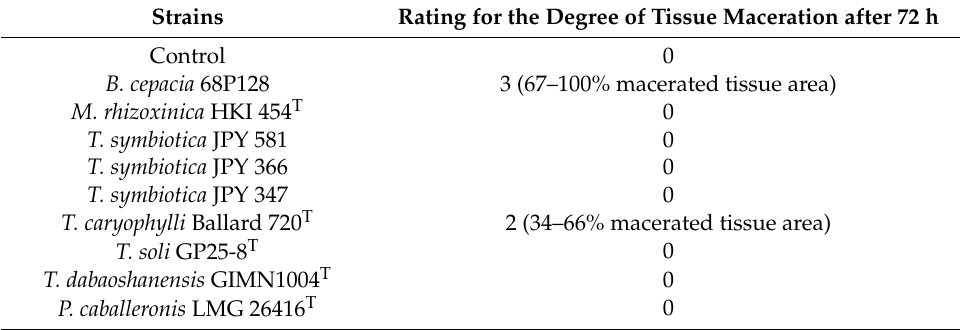
Table 3. The pathogenicity of the Mycetohabitans and Trinickia strains on onion bulb scales ( Allium